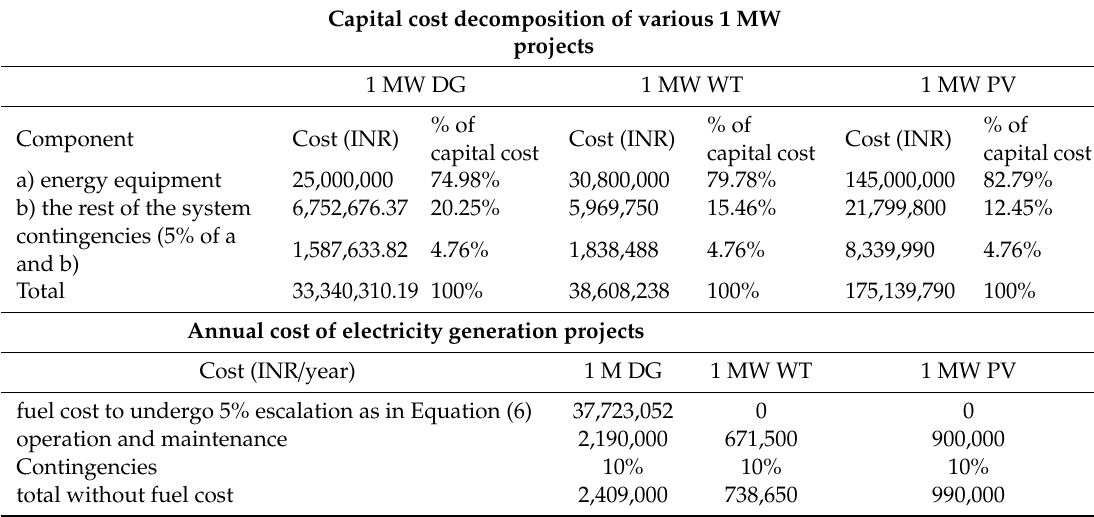
Figure 2. Cost of the project (capital cost components and operation and maintenance cost). Table 1. Capital and annual cost decomposition of various 1 MW electricity generation projects.